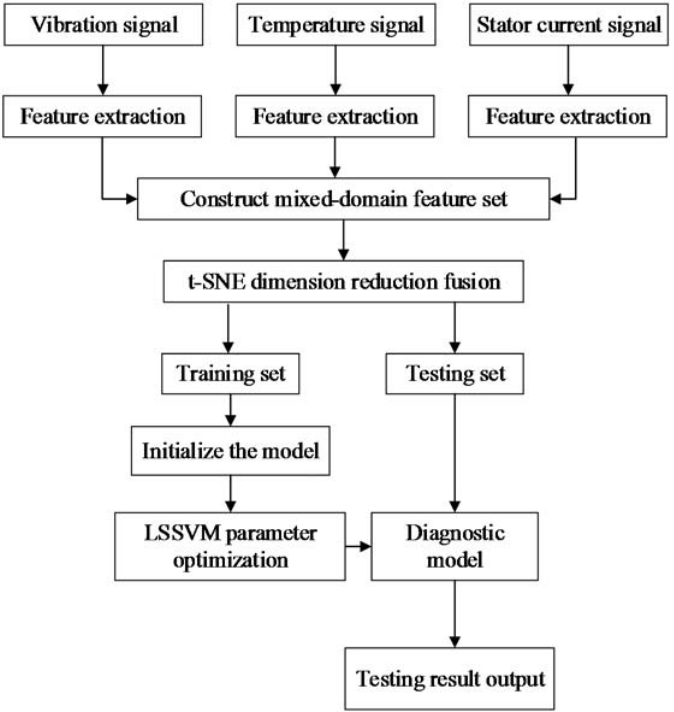
Figure 3. The fault diagnosis process. Table 3. Results of different fault diagnosis methods.